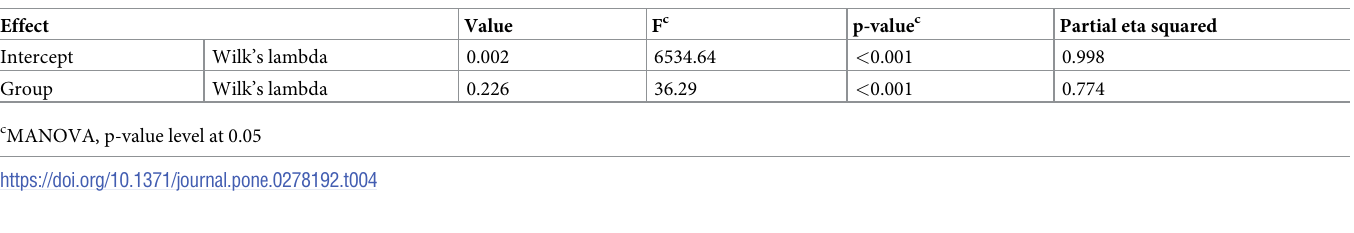
Table 4. Overall effect of the MyPinkMom intervention program on all dependent variables at week 6 (immediately post